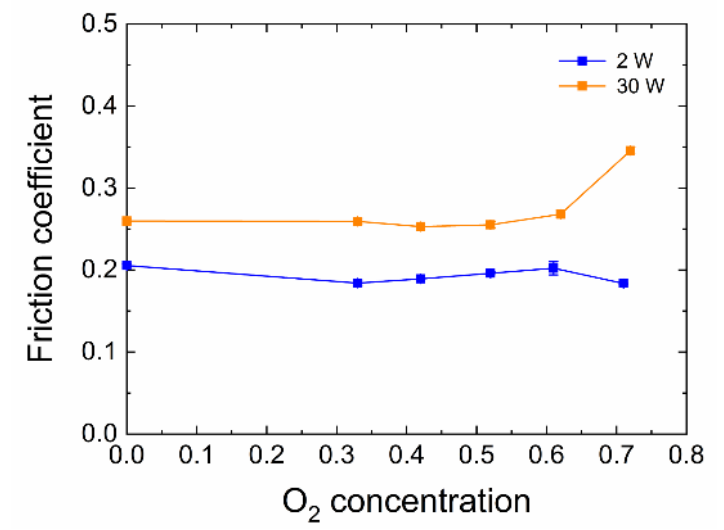
Figure 9. Graph of the friction coefficient vs. oxygen concentration.